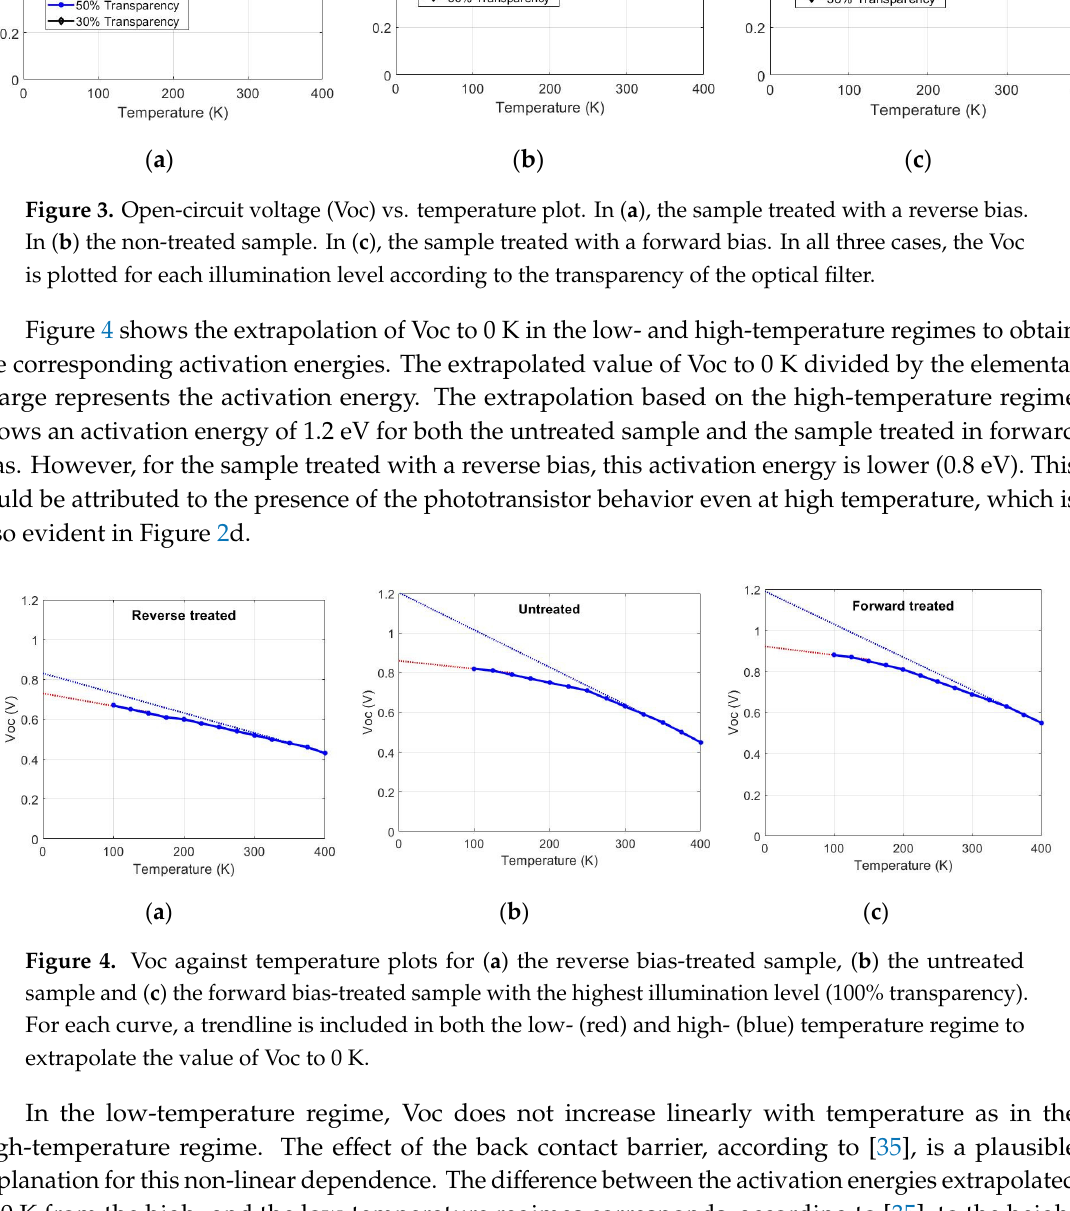
Figure 5. Curves of the apparent doping level against the depth of the space charge region at 300 K for the untreated sample and the samples treated in forward and reverse bias.